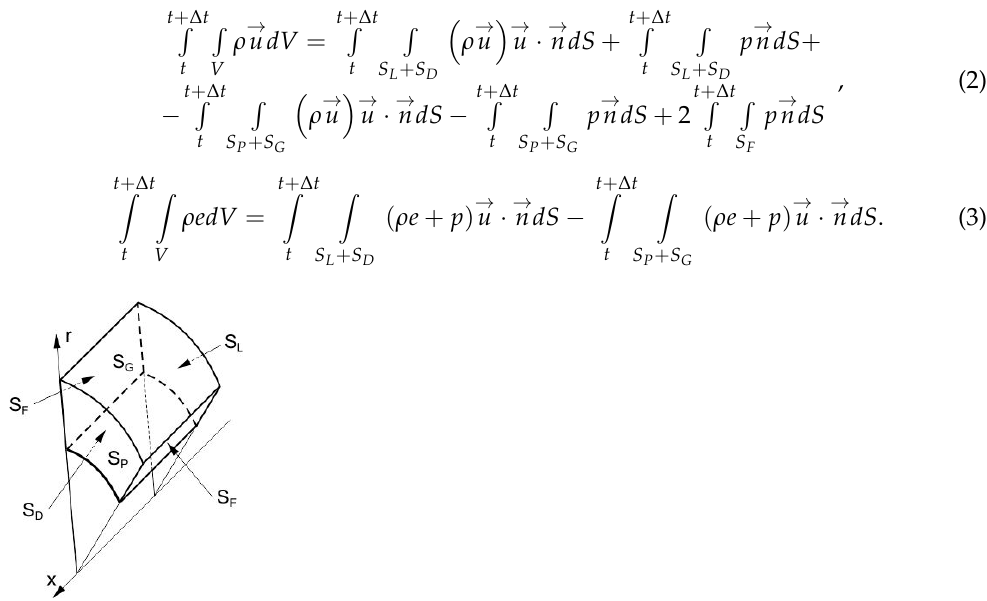
Figure 3. Space cell for which the balance equations are defined. These equations contain the time variable t , axial and radial variables x and r , flow velocity u , density ρ , pressure p , specific energy e , normal vector n , volume V and surface area S . The partitioning of the primer and the chamber interior into cells is illustrated in Figure 4.